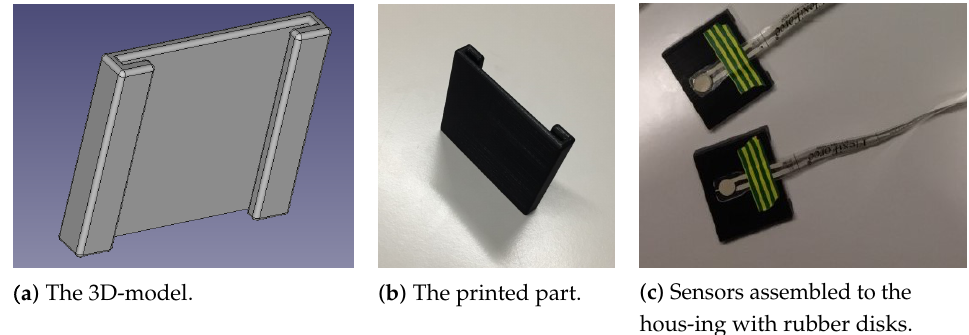
Figure 2. The 3D-model, the printed model and the assembly of the "U" shape.